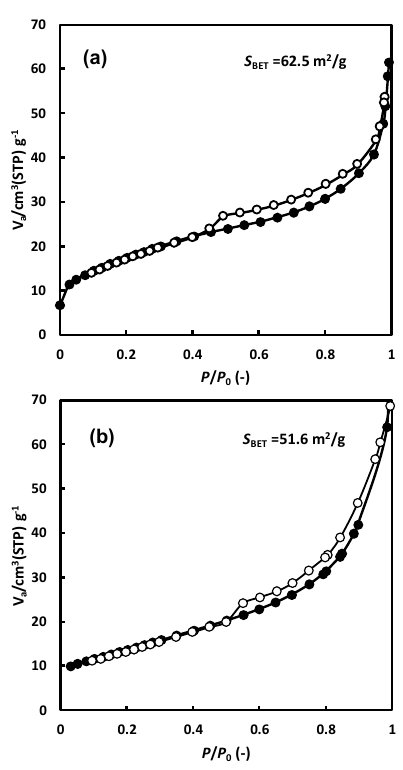
Figure 5. N 2 isotherm of SAOs prepared by ( a ) hydrothermal reaction and ( b ) sol–gel method.